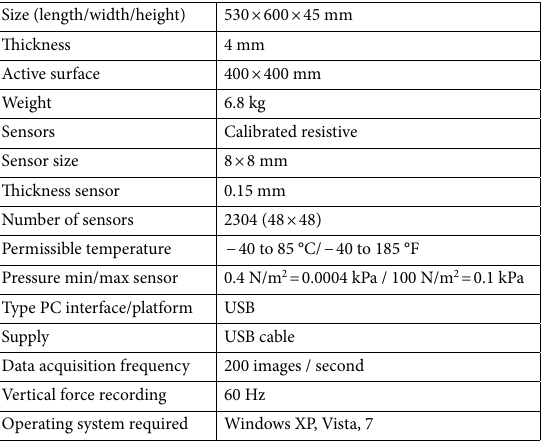
Table 1. Technical specifications of force platforms. Abbreviations: mm millimetres, Kg kilograms, °C degrees Celsius, °F degrees Fahrenheit, N/m 2 Newton/square metre, kPa kilopascals, Hz Hertzios.